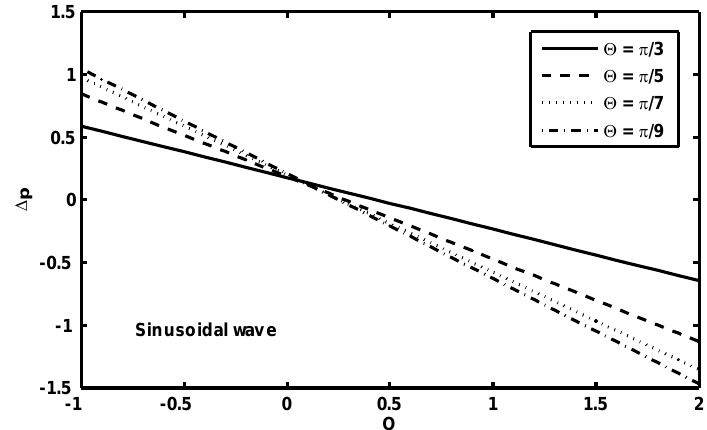
∆ p with Q for di ff erent values of Re for fixed a = 0.7, α = 0.2, b = 0.7, d = 1.5, Θ = π = 0.4, M = 0.5, ϕ = π , λ 6 1